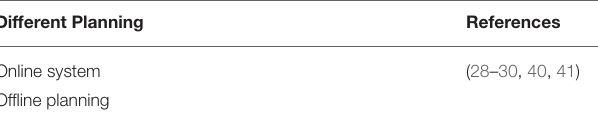
TABLE 5 | Taxonomy relies on the